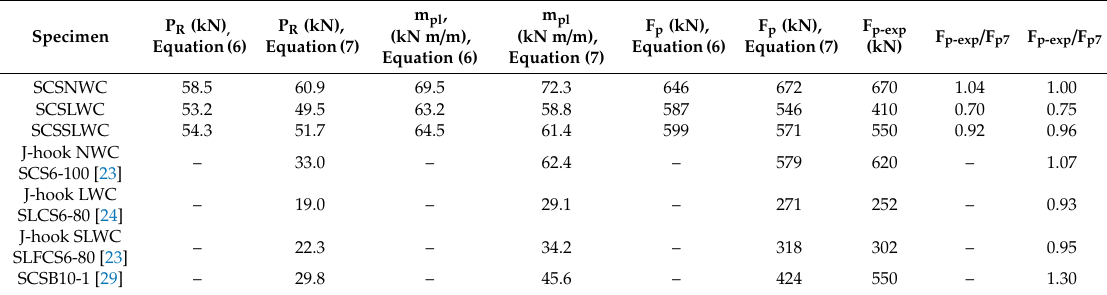
Table 11. Comparisons between theoretical predictions and test results of SCS